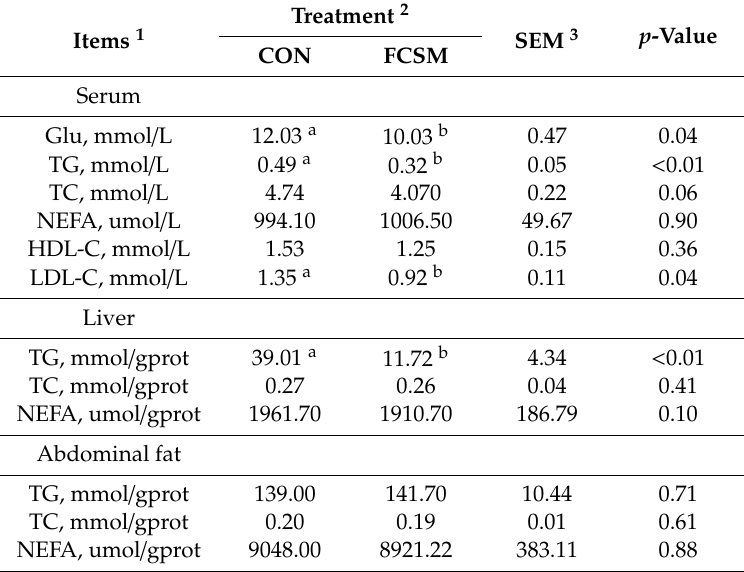
Table 4. Lipid-related indices in broiler serum, liver, and abdominal